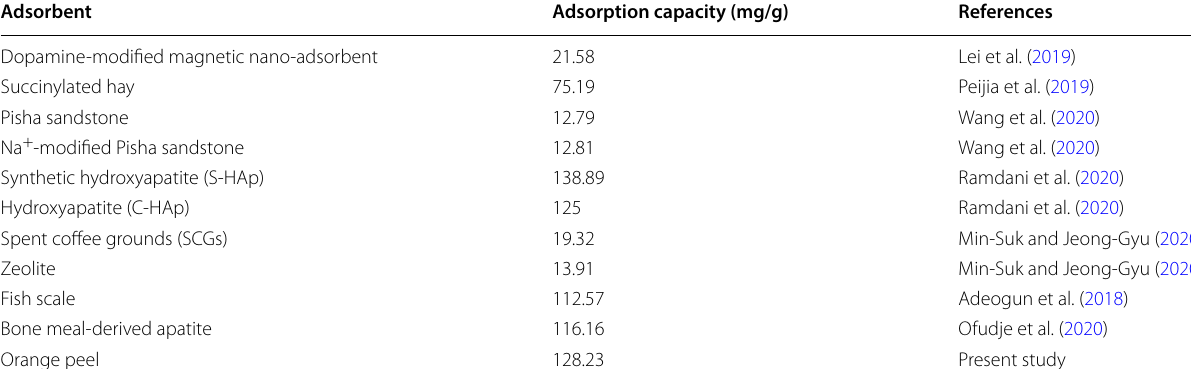
Table 3 Comparable adsorption capacities of other adsorbents with orange peel